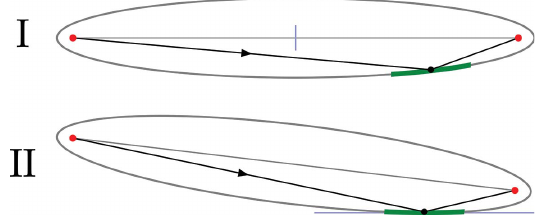
Figure 1 Three types of elliptical mirror elements: ( a ) annular ellipsoid, ( b ) ellipsoidal surface, ( c ) plane-elliptical surface. Shapes ( a ) and ( b ) are portions of a parent ellipsoidal surface. The coordinate axes used in these descriptions are